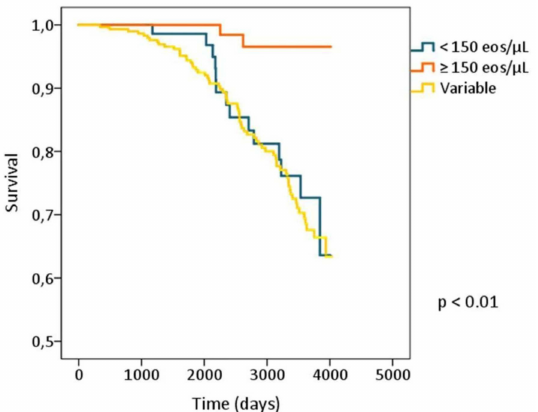
Figure 2. Survival in relation to blood eosinophil. Kaplan–Meier plots showing survival in smokers with blood eosinophils persistently < 150 cells µ L − 1 , persistently ≥ 150 cells µ L − 1 and variable (oscillating above and below 150 cells µ L − 1 ) over the 5 yearly blood samples. p -value <